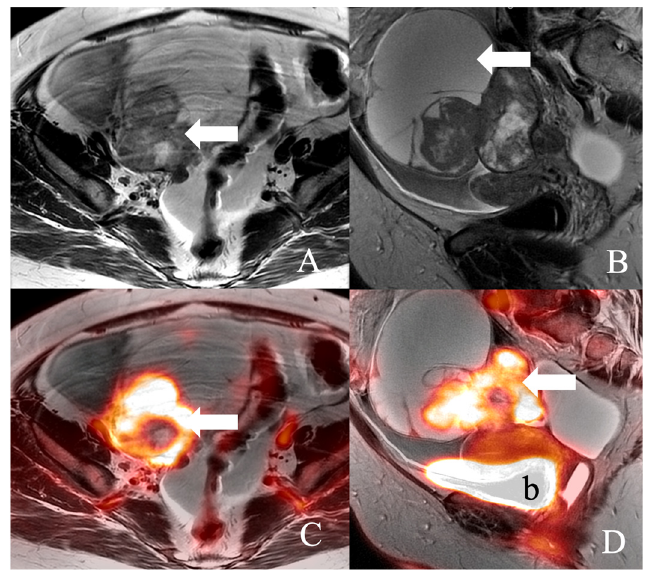
Figure 3. 49-year-old female with high-grade Mullerian carcinoma of the right ovary. ( A ) Axial T2WI, ( B ) Sagittal T2WI MR images, and ( C ) Axial fused T2WI. ( D ) Sagittal fused T2WI positron emission tomography/MRI images demonstrate a large complex right adnexal mass (arrow) with an enhancing soft tissue component within the mass. b, urinary bladder. Cytoreductive surgery is the standard of care for patients with ovarian cancer [86]. Table 6. Characteristics of PET/MRI studies in recurrent gynecological tumor to NAC is assessed by monitoring the CA-125 levels before and after the NAC [94].